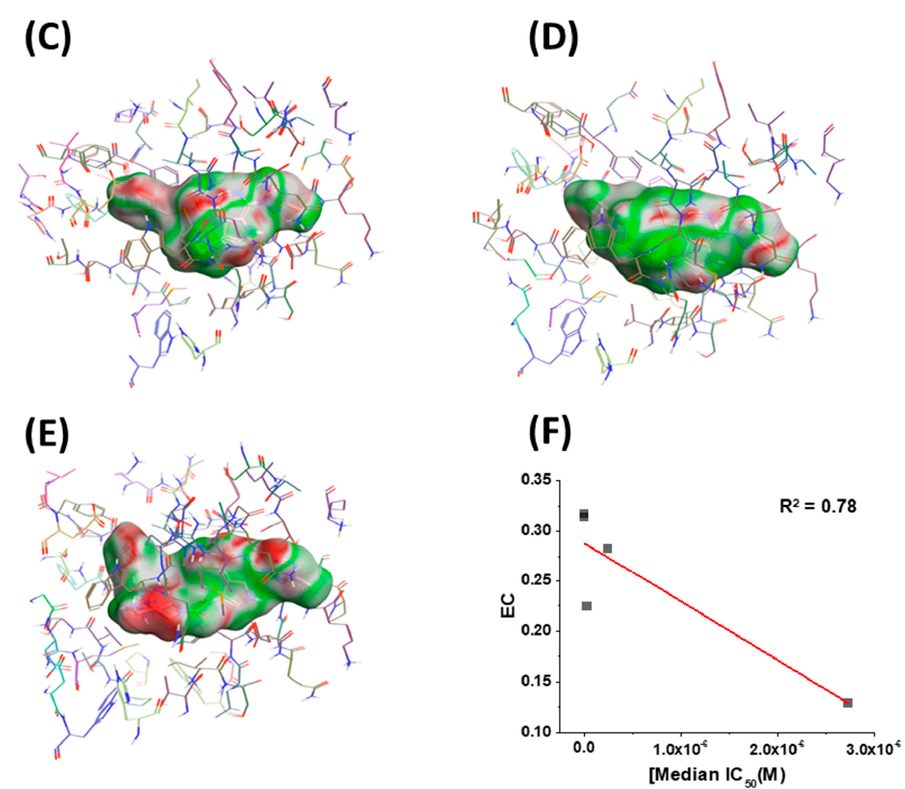
Figure 5. Electrostatic complementarity (EC) of the binding site in BG505 SOSIP.664 gp140 trimers and ( A ) BMS-626529, ( B ) SC11, ( C ) SC16, ( D ) SC18, and ( E ) SC39. ( F ) EC score plotted versus median IC 50 . Red line shows a linear trend line. Regions of the ligand surface where there is perfect electrostatic complementarity with the protein are colored green, while the regions where there is a perfect electrostatic clash are colored red.